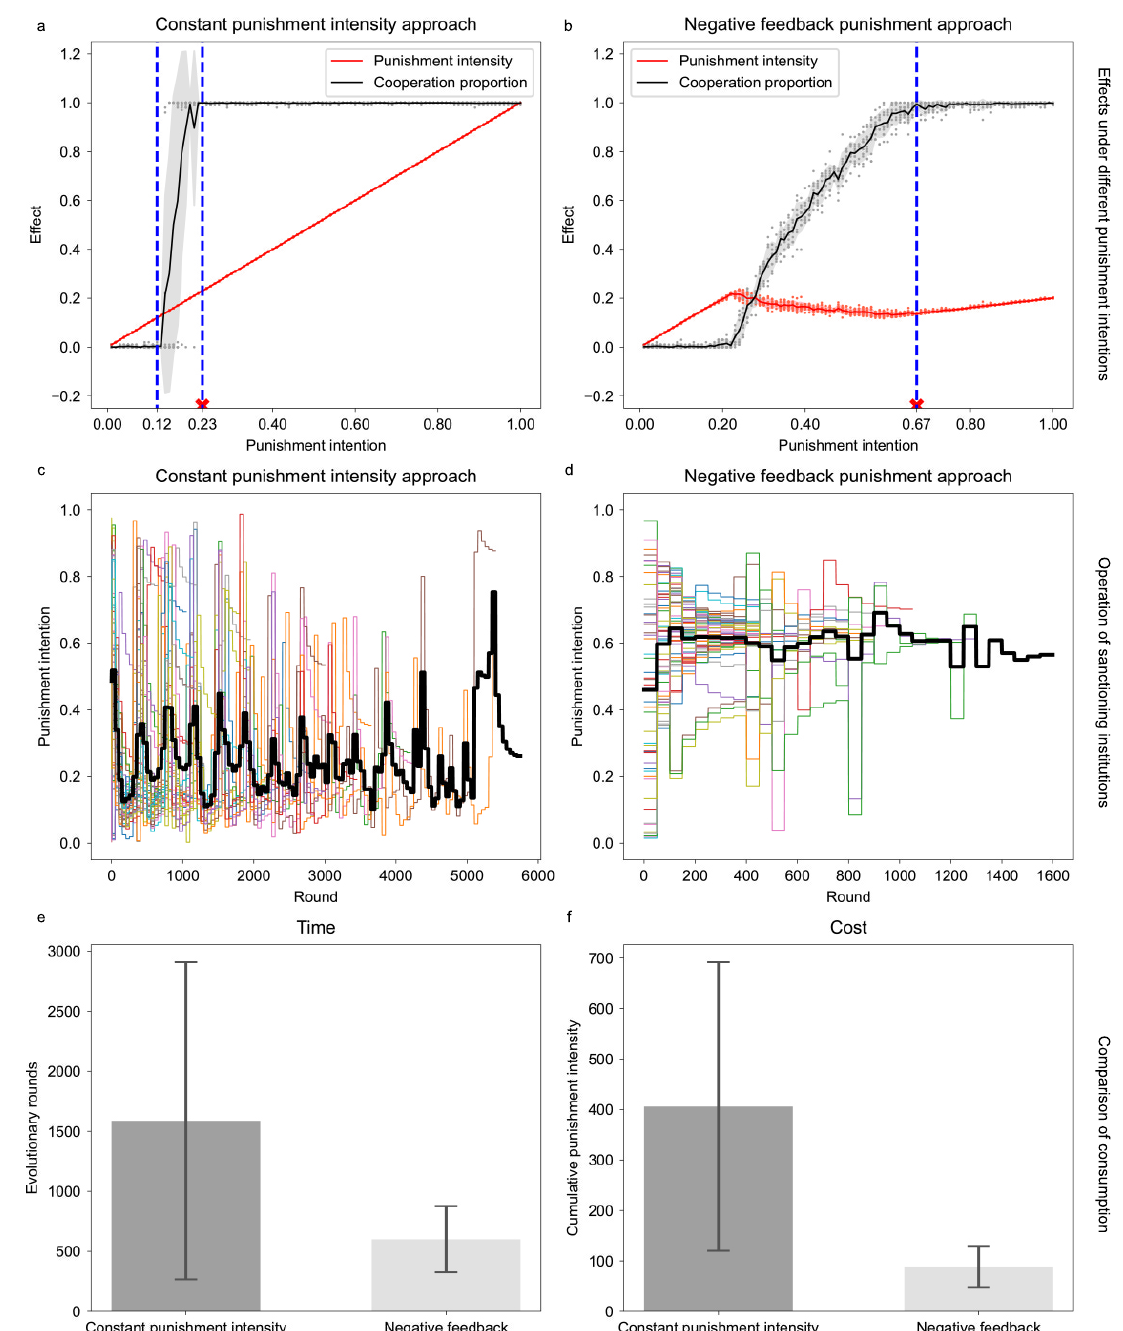
Figure 2. A group under different punishment methods. ( a , b ) The effect of punishment intention under the constant punishment intensity approach and the negative feedback punishment approach, respectively. The sampling interval of punishment intention is 0.01 in our simulation. ( c , d ) The 50 operation processes of the sanctioning institution under the constant punishment intensity approach and the negative feedback punishment approach, respectively. One colorful line depicts one operation, and the black line shows an average over 50 repetitions. Based on the operations, we compare the two methods in terms of time and cost in ( e , f ), respectively. Bar heights in ( e , f ) indicate the mean evolutionary rounds and the average of the cumulative punishment intensity, respectively. Error bars represent standard errors. The detailed setup of the simulation environment is shown in the Appendix